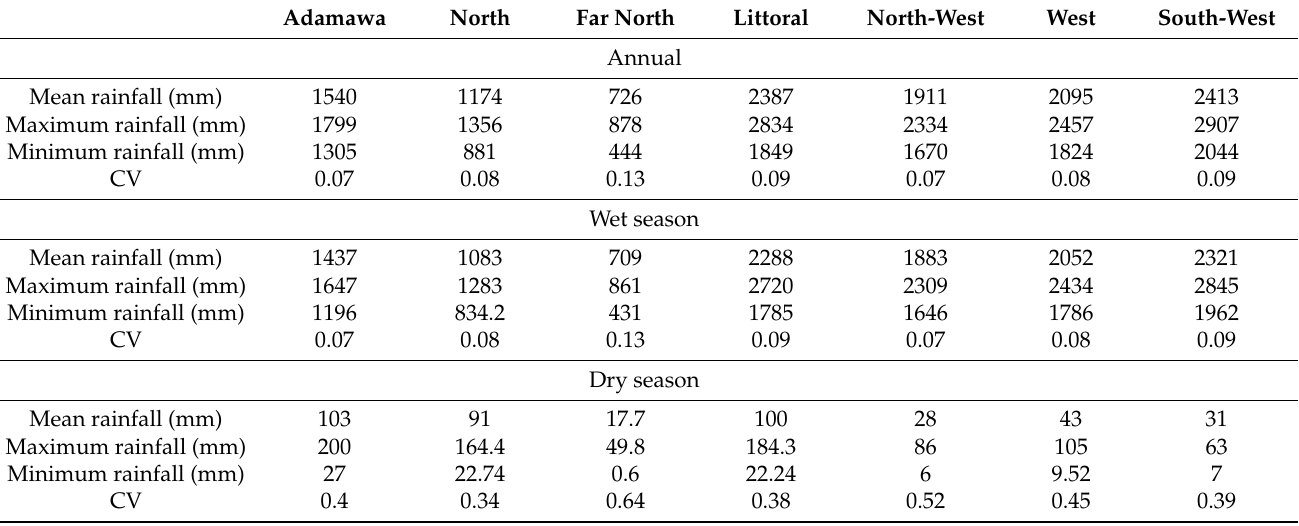
Table 2. Statistical properties of annual and seasonal rainfall for the northern regions (Adamawa, North, and Far North) and western regions (Littoral, North-West, West, and South-West) of the country. Each of these regions has 2 seasons.